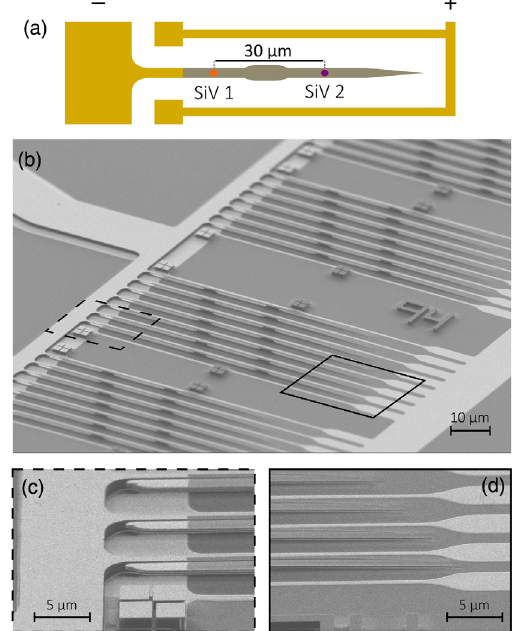
FIG. 2. Characterization of dc and ac voltage response of the devices. Voltage bias is applied to the capacitor plates, resulting in strain fields that tune the optical transitions of SiV1 in the deflected portion of the device (orange) compared to the optical transitions of SiV2 in the stationary regions (purple). The tuning range of the SiV color center greatly exceeds the inhomogeneous distribution for 50% (75%) of SiV color centers observed in this experiment shown in dark (light) blue shading. The right-hand inset shows the photoluminescence excitation spectra of two color centers at a voltage near the overlap. The left-hand inset shows the ac response of the cantilever system, measured by observing SiVoptical transitions while modulating the ac driving frequency. Driving the cantilever resonance with its mechanical mode results in linewidth broadening of the color center optical